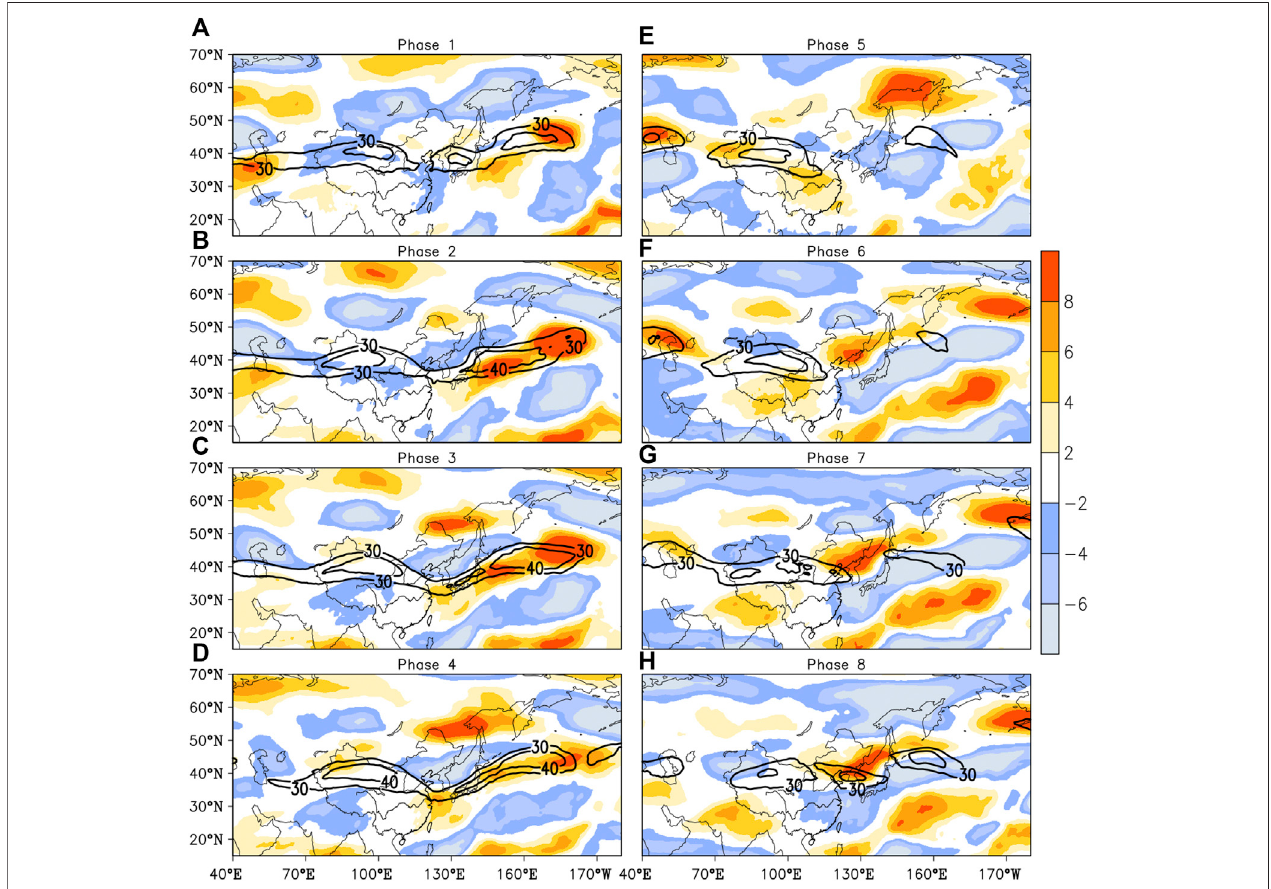
FIGURE 12 | As in Figure 10 but for fi fth and sixth rainfallprocesses. A – H correspond to the eight phases of the composite evolution ofQWBO component of the the second to third rainfall processes.